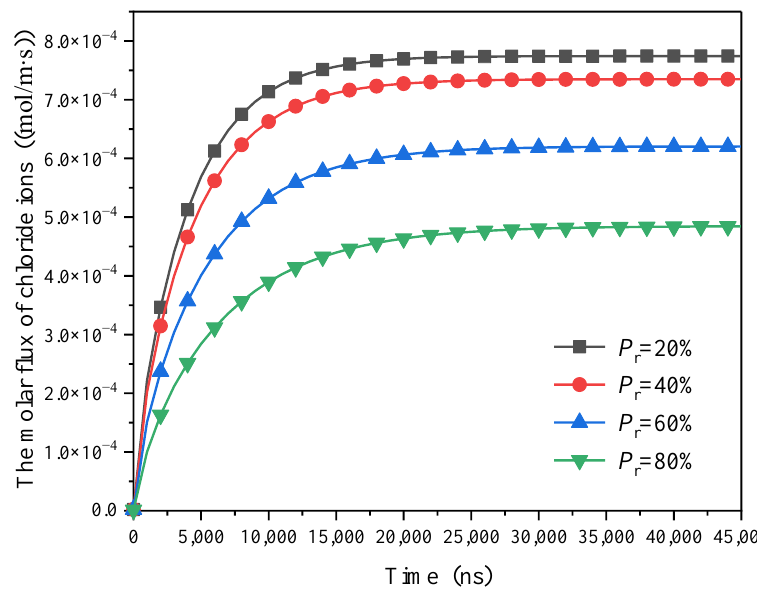
Figure 10. The influence of the ratio of HD C-S-H on molar flux of chloride ions.